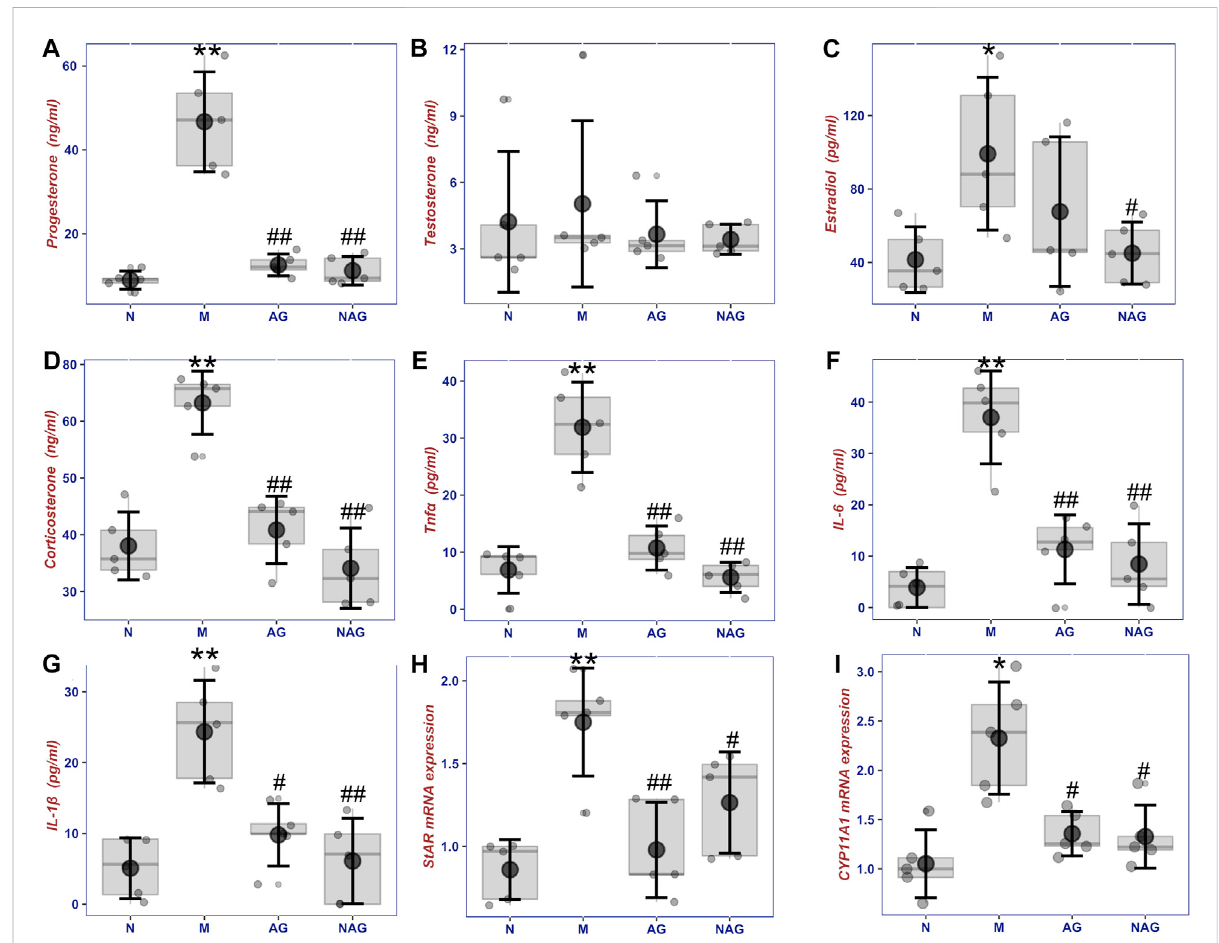
FIGURE 8 The box plot of sex steroids including progesterone (A) , testosterone (B) , estradiol (C) and corticosterone (D) , in fl ammatory cytokins including TNF- α (E) , IL-6 (F) and IL-1 β (G) concentrations in serums, and the sex hormone synthesis gene expression (H) and (I) in ovories in normal group (6, N),normalwithAGadministrationgroup(6,AG40 mg/kg,NAG),modelgroup(6,LPS100 μ g/kg,M)andhighdose(6,LPS100 μ g/kg+AG40 mg/kg, AG) groups. * p < 0.05 or ** p < 0.01 versus Normal group and # p < 0.05 or ## p < 0.01 versus Model group by